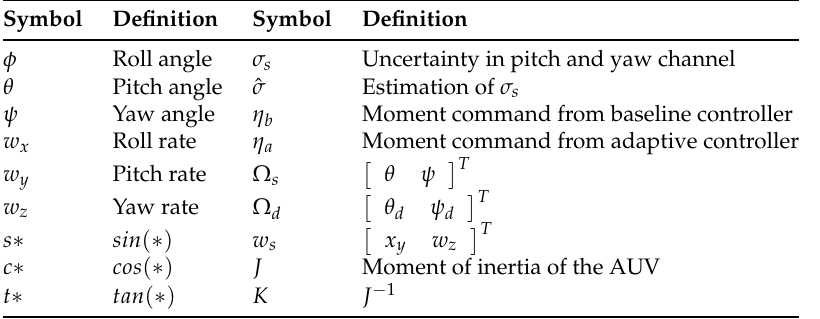
Table 1. Definitions and